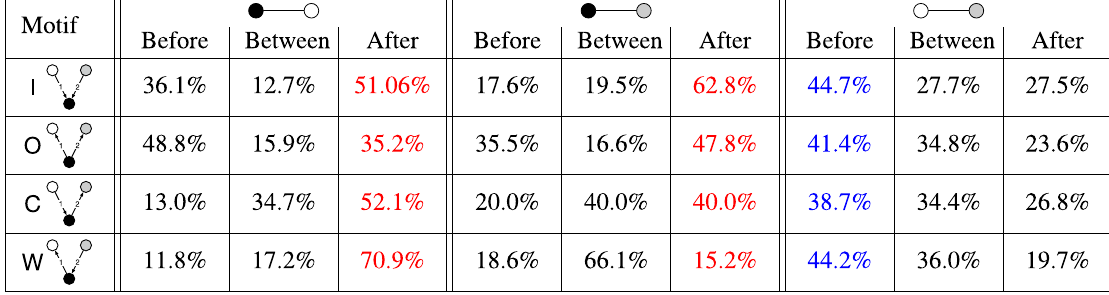
Table 5. Timing of collaboration events occurring on top of opposition motifs. For each type of opposition motif and each edge in the motif, we show the fraction of collaborations that occur before all oppositions, between the two oppositions, and after all oppositions. The collaborations between two nodes with an opposition relation tend to occur after all opposition events (red), whereas the collaborations between two nodes with no opposition relation tend to occur before all opposition events (blue).